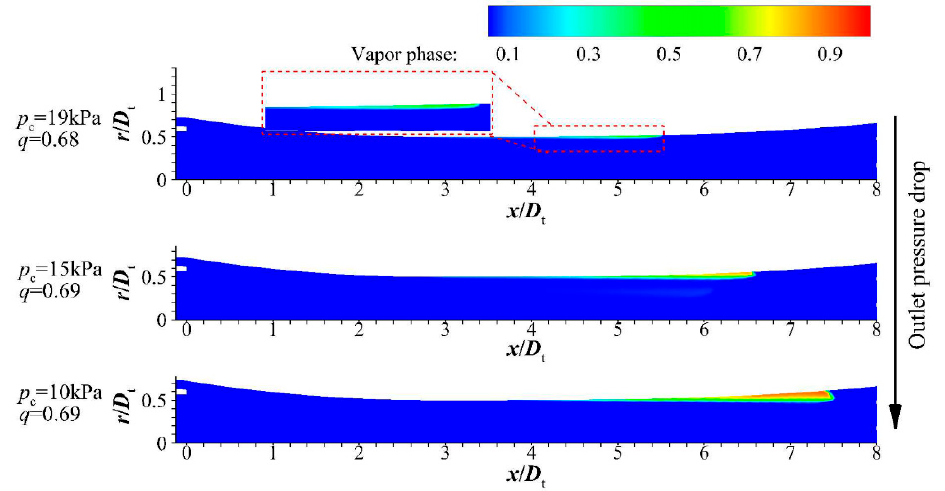
Figure 14. Pressure and vapor volume fraction distribution (STR, q = 0.57). ( a ) Pressure distribution; ( b ) Vapor volume fraction distribution. Energies 2020 , 13 , 4411 13 of 15